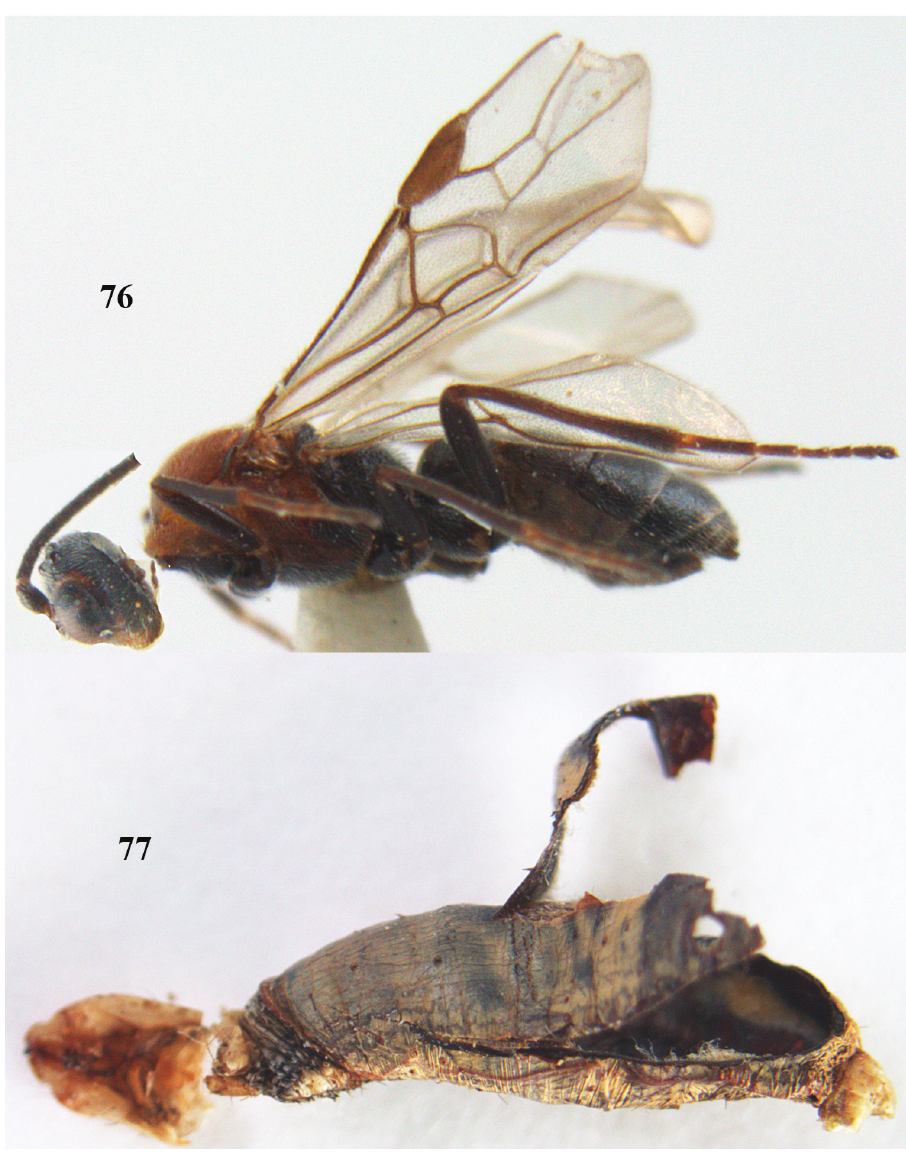
Figures 76–77. Aleiodes artesiariae sp. n., ♀ , holotype. 76 habitus lateral 77 mummy of Macaria artesiaria (Denis & Schiffermüller) after extraction of adult. Wings. Fore wing: r 0.7 × 3-SR and linear with 3-SR (Fig. 78); 1-CU1 oblique and widened, 0.25 × as long as 2-CU1; r-m 0.8 × 2-SR, and 0.7 × 3-SR; second submar- ginal cell rather small and square (Fig. 78); vein M+CU1 of fore wing apically above level of vein 2-CU1 (Fig. 78); vein 1-SR of fore wing angled with vein 1-M; cu-a sub- vertical, not parallel with CU1b, straight; 1-M straight posteriorly. Hind wing: